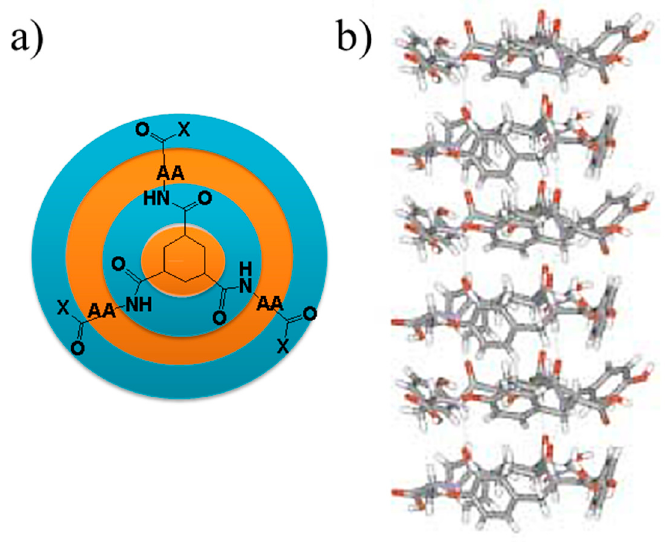
Figure 6. ( a ) Scheme showing the hydrophobic (blue) and hydrophilic (orange) regions of a cyclohexane-based hydrogelator having amino acids (AA) with hydrophobic side groups; ( b ) a single strand formed through the multiple hydrogen bonds that each single molecule can establish.